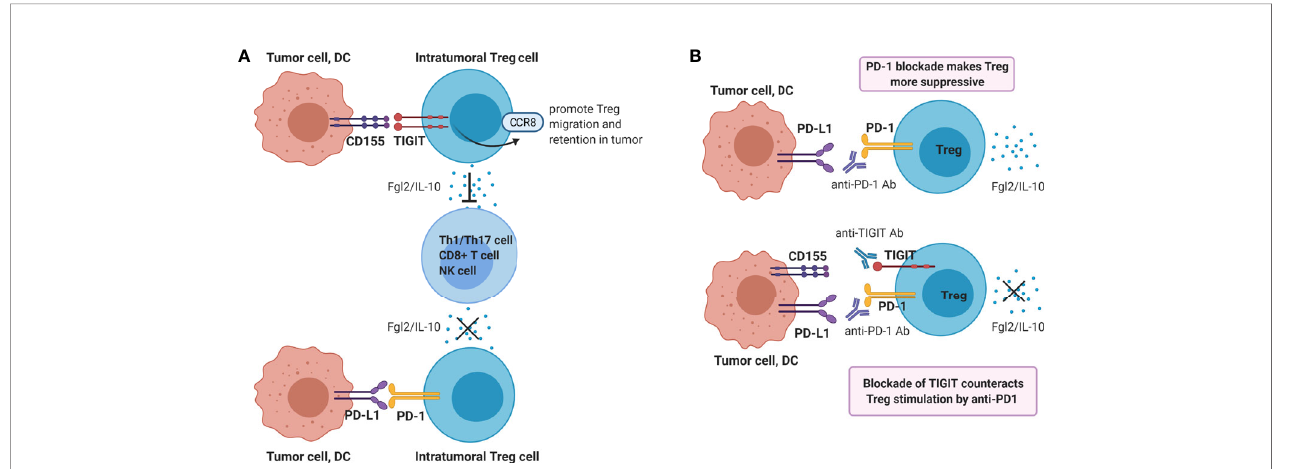
FIGURE 3 | Ligation of TIGIT on Tregs contributes to dampening of anti-tumor immunity. (A) Ligation of TIGIT augments suppressive function of Tregs, which inhibits Th1/17 cell, CD8 + T cell or NK responses via production of Fgl2 and IL-10. On the contrary, PD-1 ligation may reduce Treg suppressive function. (B) Single blockade of PD-1 may enhance Treg immunosuppression, whereas dual blockade of TIGIT and PD-1 may counteract this resistance